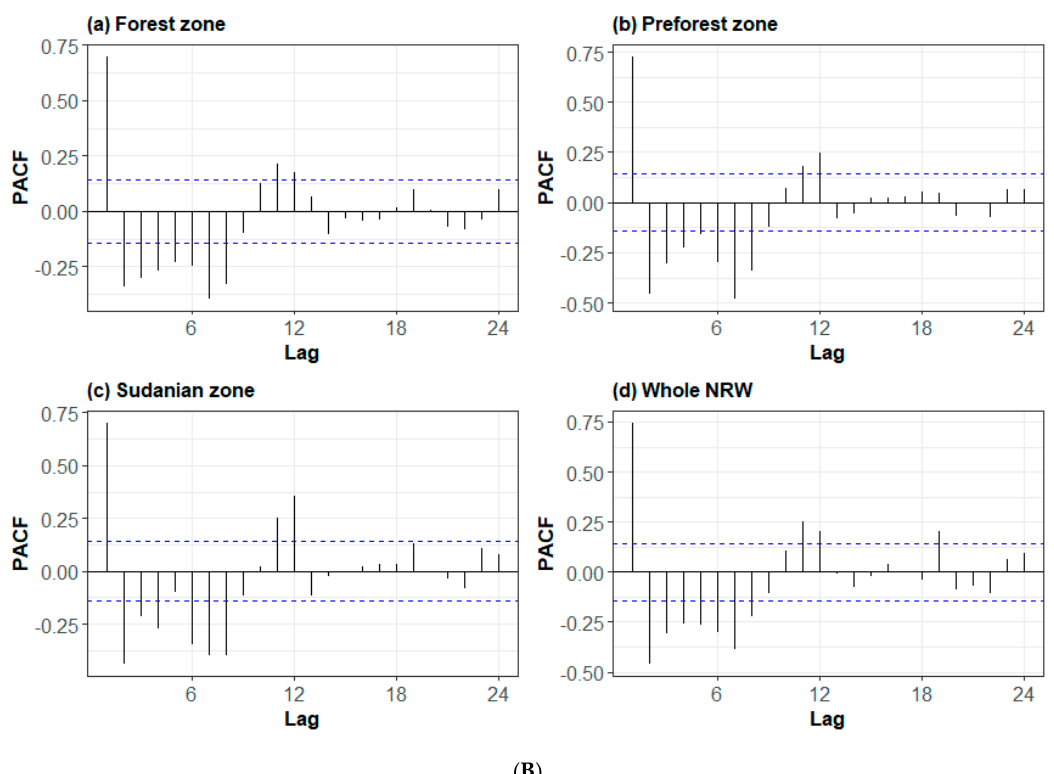
Figure 4. Partial autocorrelation functions of ( A ) the number of wildfires and ( B ) burnt areas. The two blue dashed lines across the plot indicate the point of statistical significance. Values